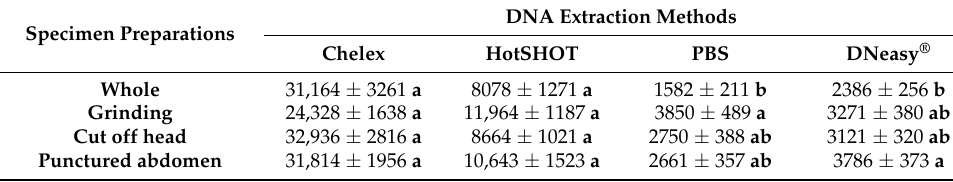
Table 3. Comparison of DNA yield ratios * expressed in ng · mg − 1 (mean ± SE, n = 14) of the specimen preparation procedures in four DNA extraction methods.